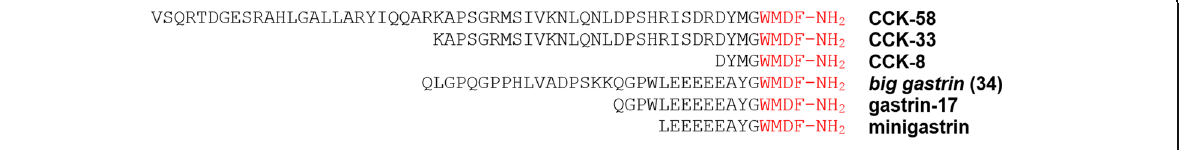
Fig. 4 Sequences of the endogenous CCK-2R ligands. C-terminal WMDF-NH 2 sequence is pharmacophoric for this